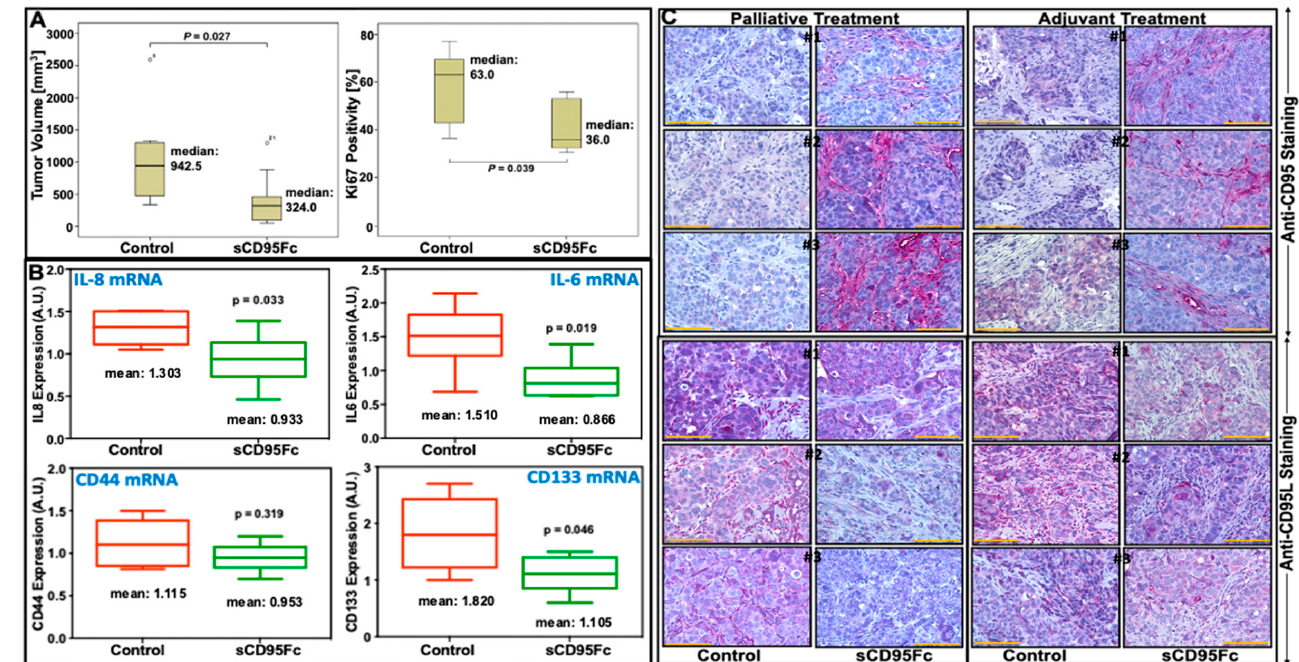
Figure 8. Impact of CD95L inhibition on tumor progression (tumor volume, Ki67 positivity, proinflammatory cytokines and cancer stem markers) and the CD95/CD95L immunostaining in tumors derived from PancTuI-luc cells under both palliative and adjuvant regimens. Female SCID beige mice ( n = 9) bearing PancTuI-luc tumor xenografts were treated i.p. with either sodium chloride 0.9% (control group) or with 25 µ g/g bwt of sCD95Fc (treated group). The tumor volume ( A , left panel) of the recurrent pancreatic tumor was determined at autopsy 4 weeks after subtotal pancreatectomy in adjuvant treatment setting. The primary tumors were resected by subtotal pancreatectomy 10 d after inoculation of pancreatic tumor cells (PancTuI-luc-1 × 10 6 ). Tissue cryo-sections of recurrent tumor specimens after adjuvant therapy regimen ( A , right panel) were immunostained for Ki67 expression and the Ki67 positivity index was calculated. Ki67 positivity of individual xenograft tumors in each group. Gene expression analysis of proinflammatory cytokines (IL8 and IL6) and pancreatic stem cell markers (CD44 and CD133) was performed as indicated in Section 2 to measure the impact of CD95L inhibition in the treated tumors. The recurrent tumor tissues ( n = 7–8) from each group were homogenized and lysed in lysis buffer; total RNA was isolated, and assayed for IL8, IL6, CD44 and CD133 via a PerfectProbe realtime RT-PCR Assay. The resulting c T -values of the corresponding genes were normalized against reference gene UBC and expressed as arbitrary units (AU) ( B ). Three representative examples from each treatment (25 µ g/g bwt of sCD95Fc) group of the palliative and adjuvant setting are demonstrated compared to respective control animals those received 0.9% sodium chloride. Staining of the tissue sections with a human antigen-specific antibody (anti-CD95 antibody) was performed as described in Section 2. Similarly, the staining is shown for the anti-CD95L antibody, which detects both the human and the murine antigen ( C ). The orange-colored scale bars represent 100 µ m. The normal distribution of the data in (8B) was tested by the Shapiro–Wilk method and in case of significance, Student’s t -test was performed and p -values and the means were indicated at the corresponding boxplots. For the tumor volumes (8A) Mann–Whitney U-tests were performed for comparison of the medians of each treated group vs. the control